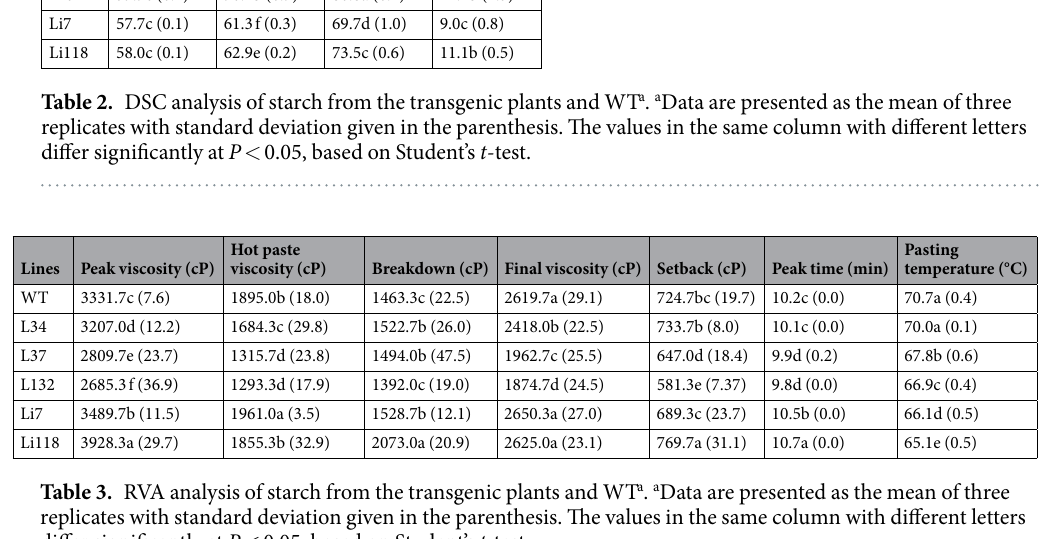
Table 3. RVA analysis of starch from the transgenic plants and WT a . a Data are presented as the mean of three replicates with standard deviation given in the parenthesis. The values in the same column with different letters differ significantly at P < 0.05, based on Student’s t